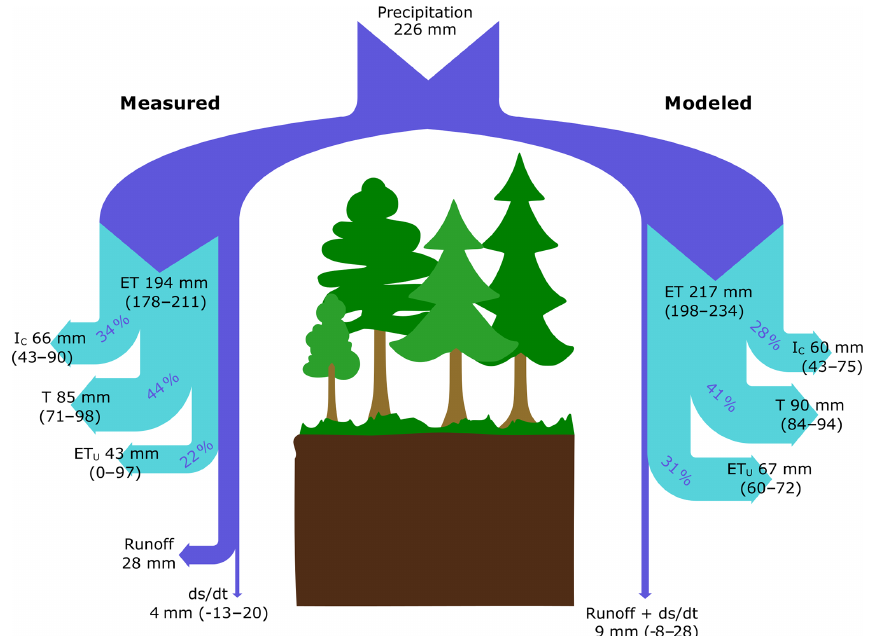
Figure 5. Partitioning of water fluxes based on empirical measurements (left-hand side) and model simulation (right-hand side) in a conifer- ous boreal catchment during the 2016 growing season (July–October). Values for each flux are presented as mean absolute values (mm) with upper and lower boundaries shown in parentheses. The percentages give the relative contribution of ET components to total